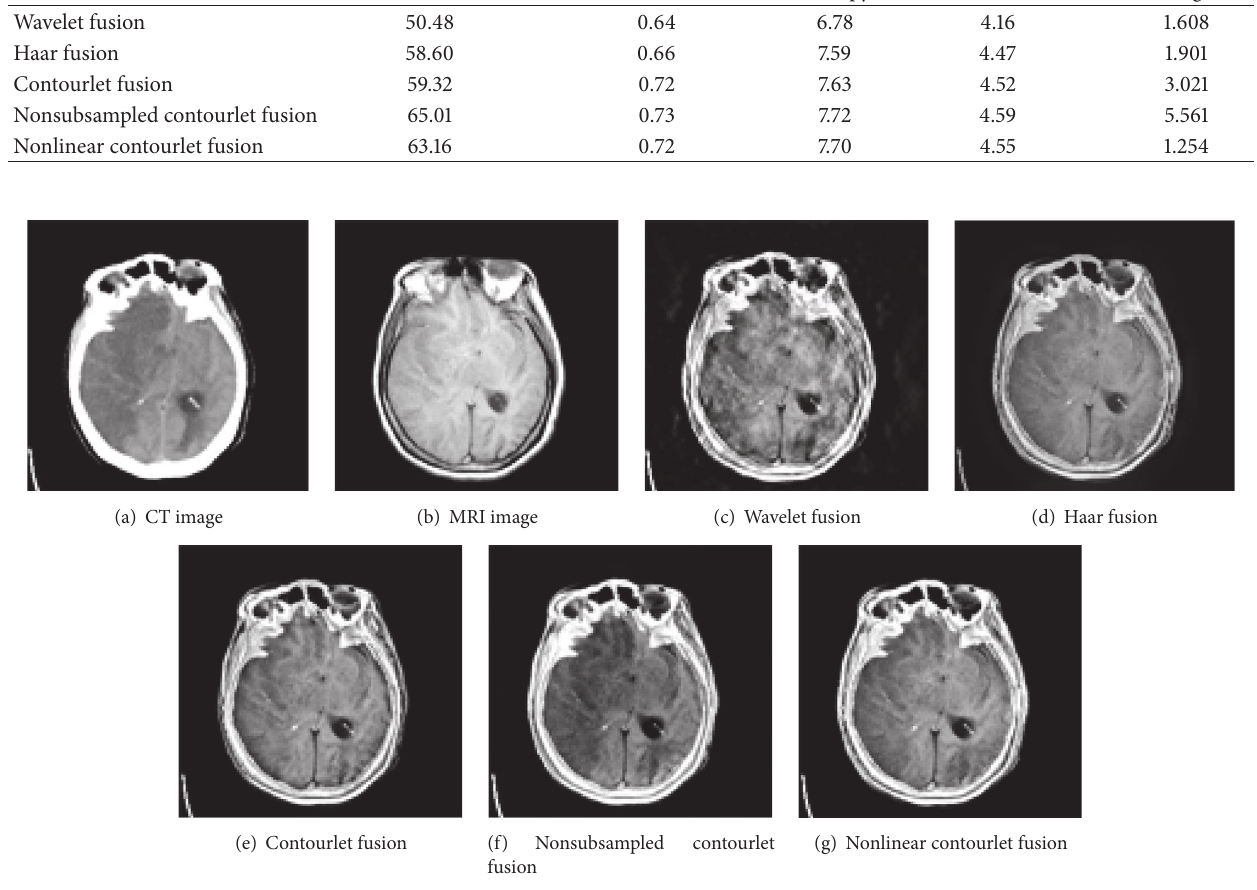
Figure 4: Fusion results’